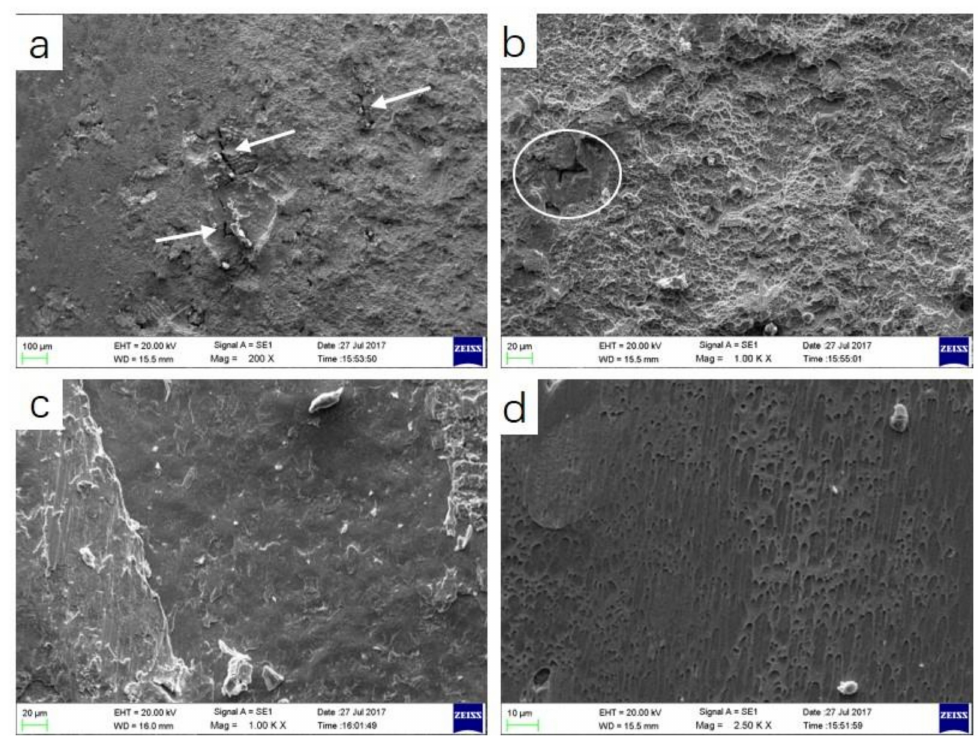
Figure 9. SEM images of an interfacial fractured specimen: ( a ) showing small cracks at low magnification, ( b ) showing brittle fracture around cracks and plastic fracture far away from cracks, ( c ) shearing surface, ( d ) stretched dimples on shearing